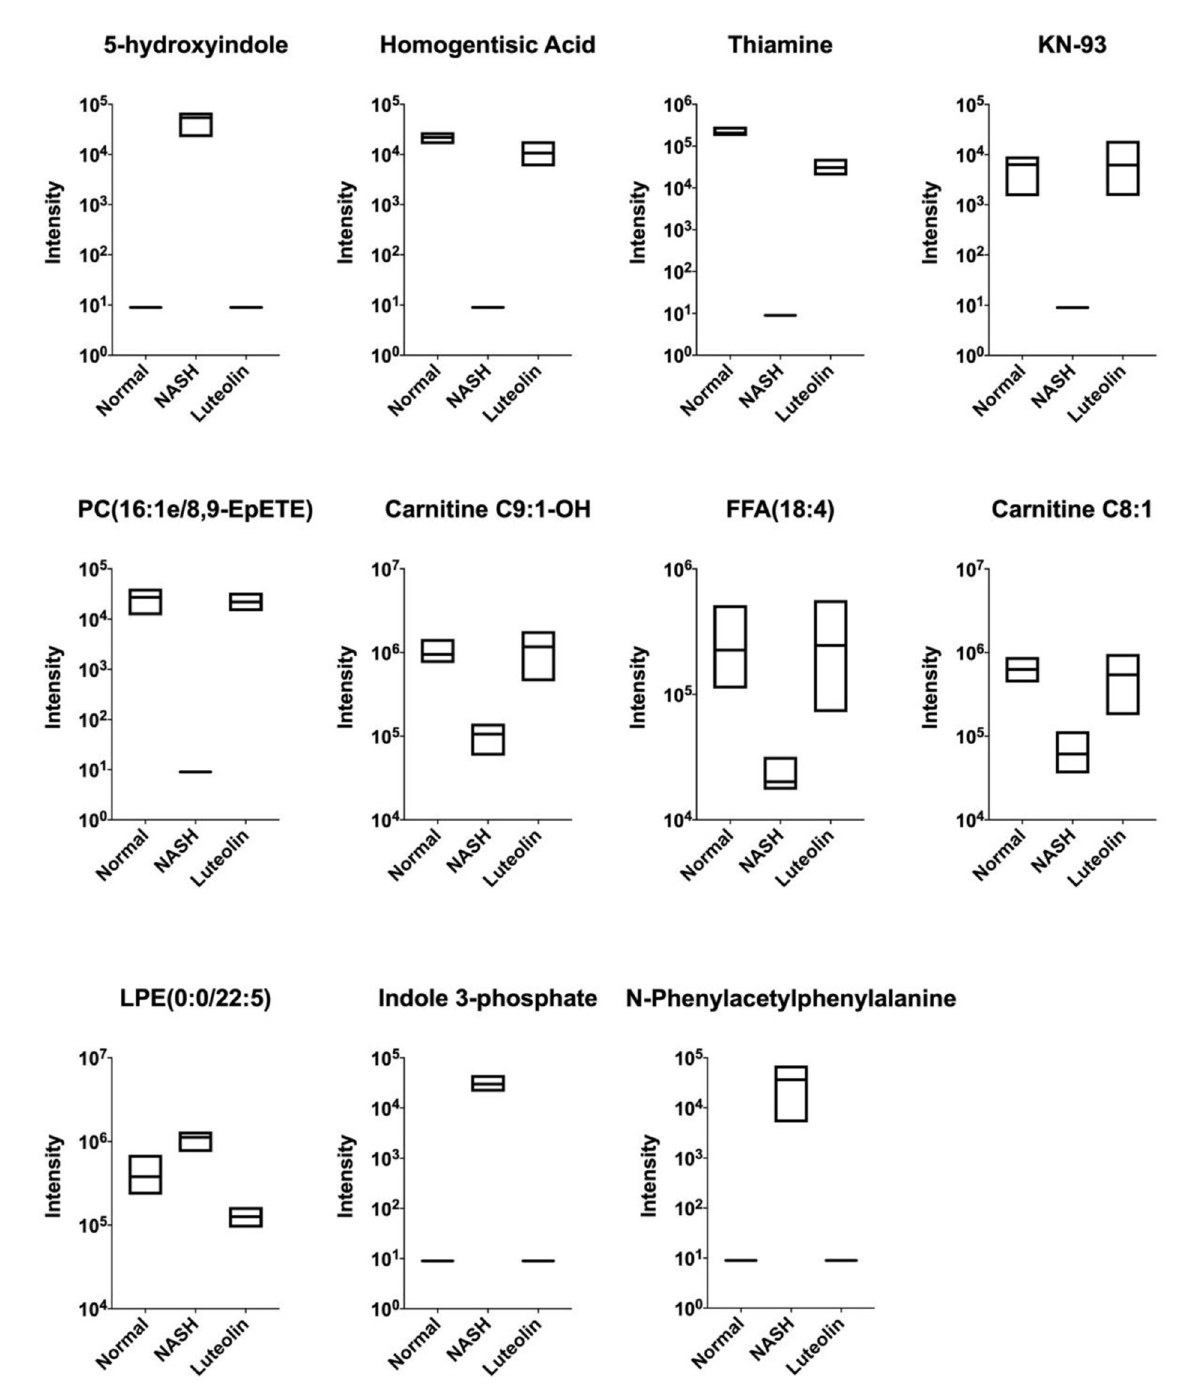
FIGURE4 Shared differentially expressed metabolites among Normal, NASH, and Luteolin groups, displayed by boxplots (the upper and lower edges of the box plot were the maximum and minimum values, respectively, while the middle line represented the median value) ( n = 6–8 per